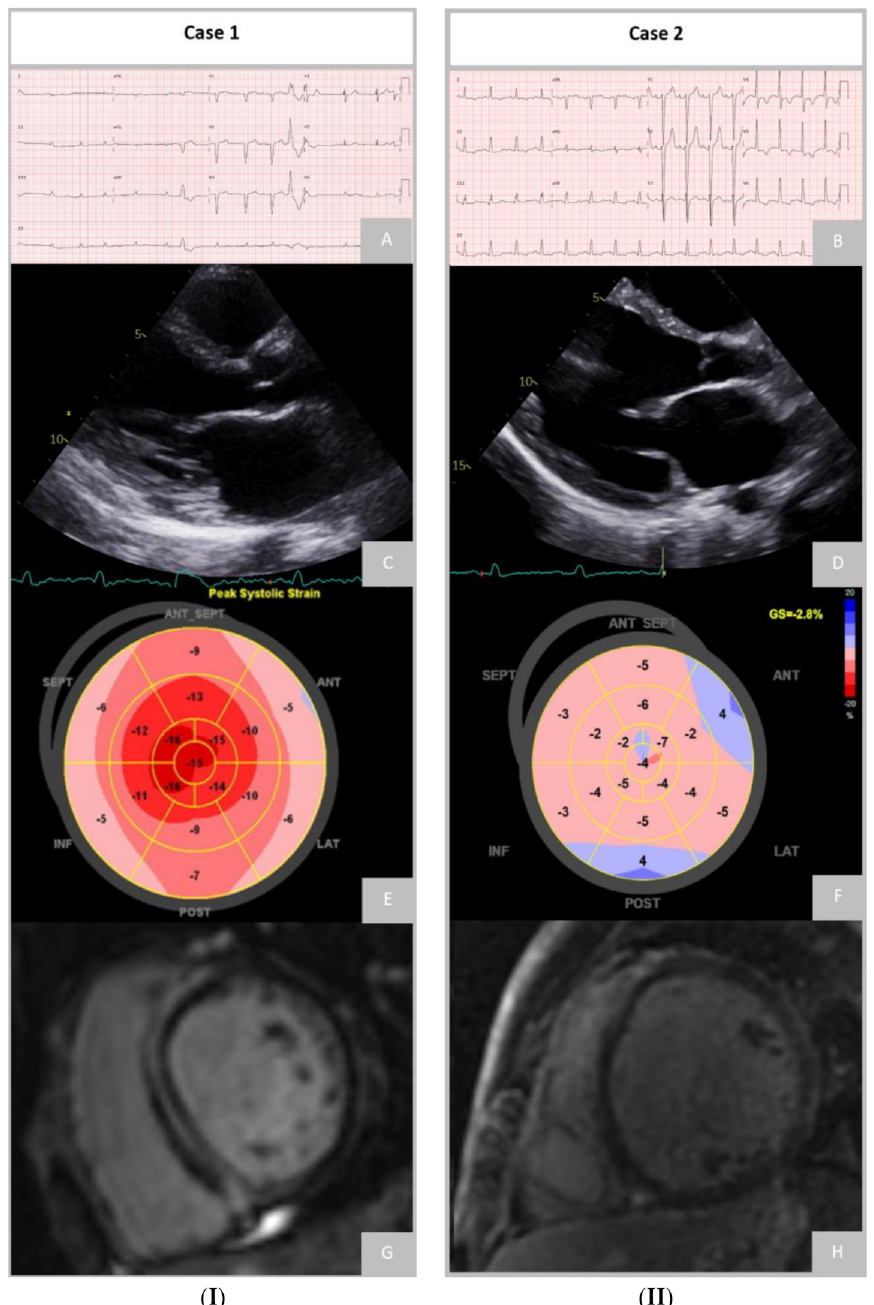
Figure 2. ( I ) Case 1 of a patient with a heterozygous variant c.1150G>T, p.(Glu384*) in the LMNA gene [NM_170707.3], classified as pathogenic, exhibiting atrial fibrillation, low QRS voltage, QS mor- phology in leads V1V3 and two polymorphic ventricular complexes on ECG ( A ); Echocardiography showing dilated left ventricle (LV) and severely reduced left ventricular ejection fraction (LVEF) (33%) and impaired global longitudinal strain (GLS), average GLS − 10.8% ( C , E ) and cardiovascular mag- netic resonance revealing a pattern of laminar intramural late gadolinium enhancement (LGE) in the septum and inferior wall ( G ). ( II ) Case 2 of a patient with a heterozygous variant c.54278_54279delCT (p.Pro18093Argfs*5) in the TTN gene [NM_001256850.1], classified as likely pathogenic, showing diffuse ST-T change on ECG ( B ); Echocardiography presented dilated LV, global hypokinesis and severely impaired LV systolic function (LVEF 12%, GLS -2.8%) ( D , F ) and no areas of LGE found on CMR ( H